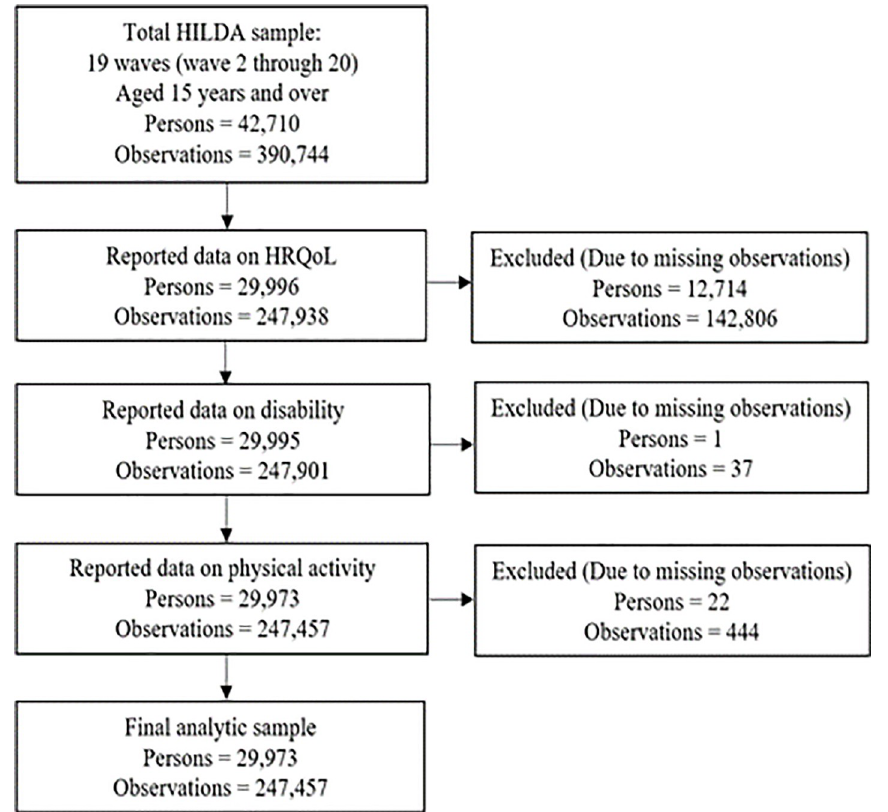
Fig 1. Participants flow into the analytic sample, and missing